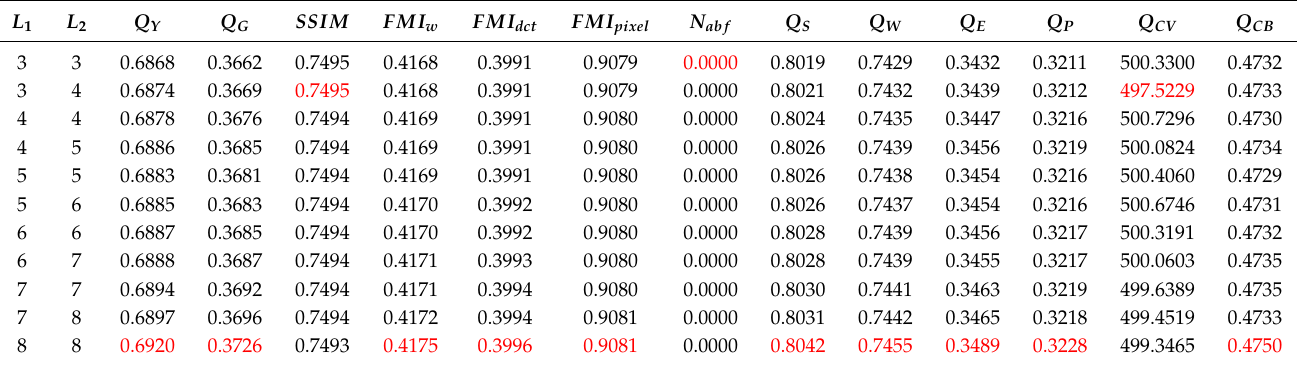
Table 1. The effect of the number of filters. L 1 and L 2 denote the numbers of first-stage and second- stage filters, respectively.